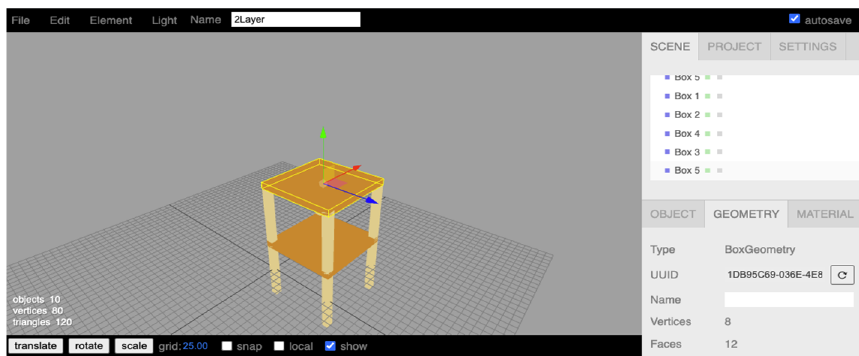
Figure 13. Two-story structure on 3D model editor of the SHM system.